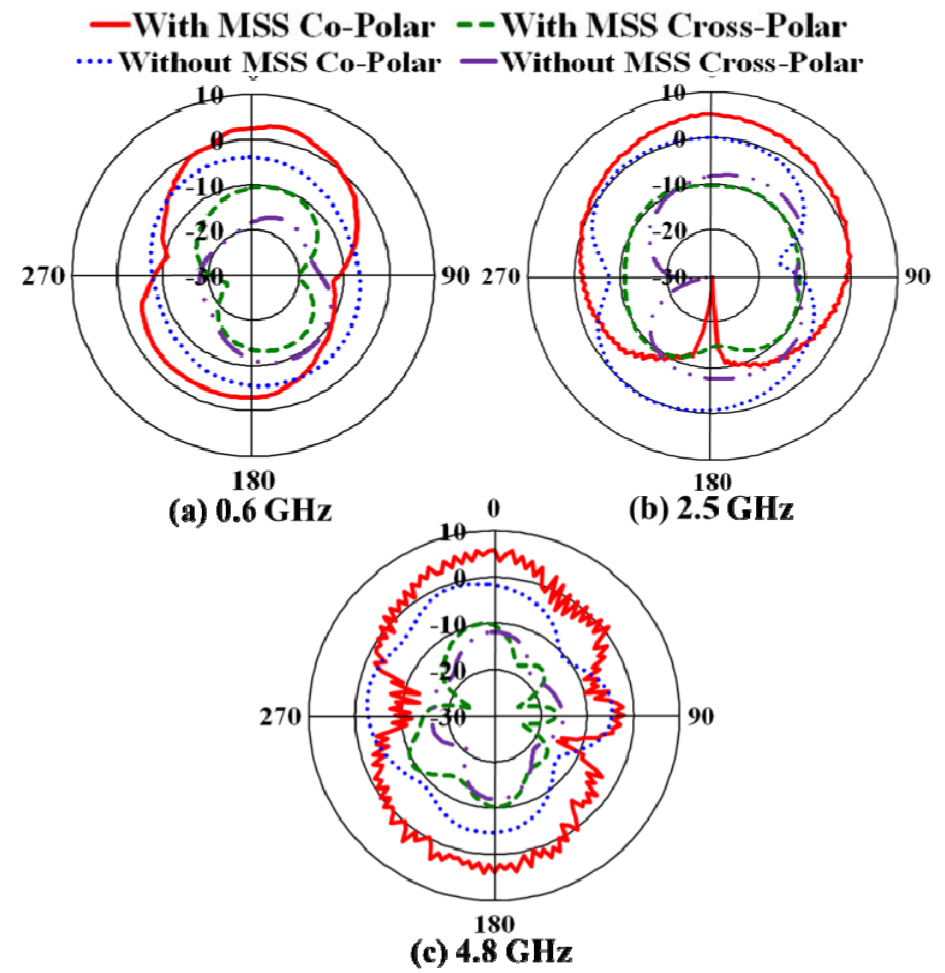
Figure 8. Measured radiation pattern of the proposed NZRI MSS antenna at three resonant frequencies.